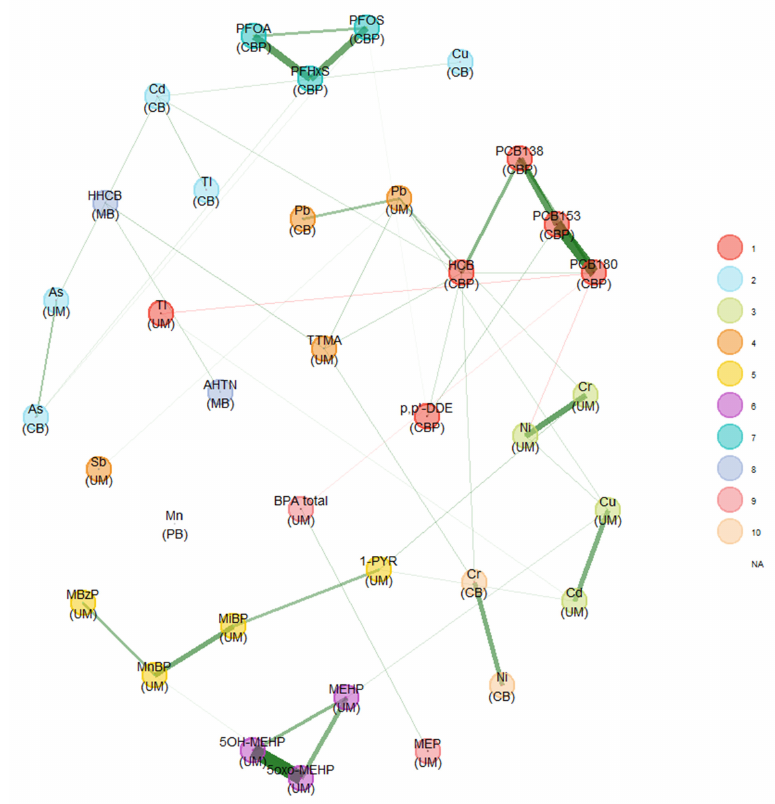
Figure A1. Weighted network for 3xG using the graphical lasso method. Data were corrected for age, smoking, and BMI. Urinary markers were standardised for creatinine; lipid soluble blood markers were standardised for lipids. Matrices in which biomarkers are measured appear between brackets. Green lines represent a positive dependency between nodes (biomarkers), while red lines represent a negative dependency.